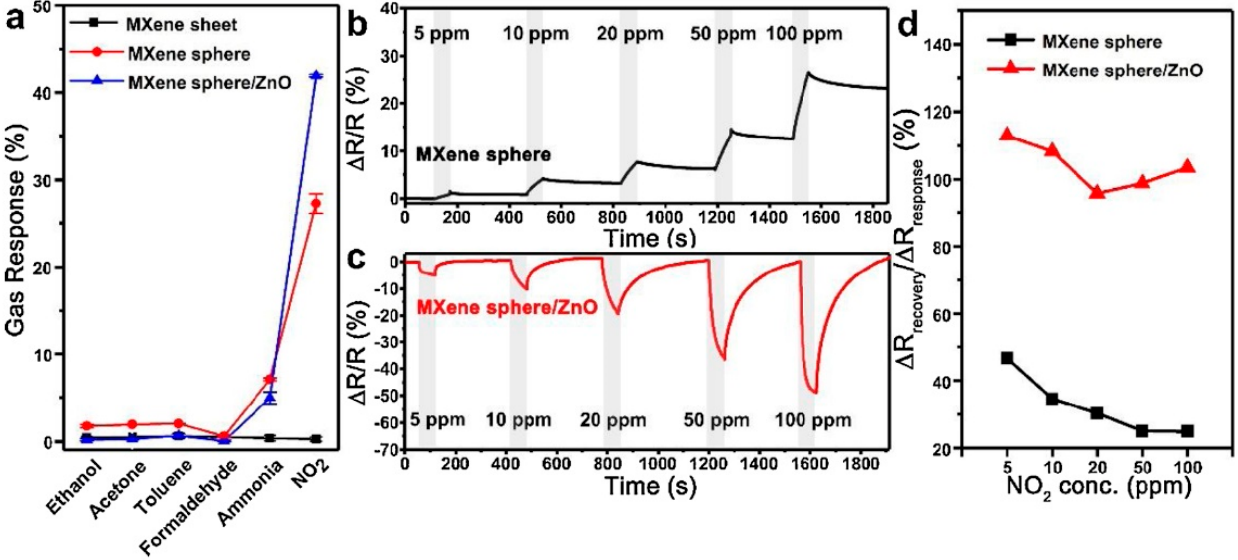
Figure 19. The selectivity, concentration sensitivity, and recovery characteristics of flexible gas sensors based on Ti 3 C 2 T x MXene sheet, 3D crumpled MXene sphere, and 3D crumpled MXene sphere/ZnO. ( a ) The gas response of sensors based on MXene sheets, MXene spheres, and MXene spheres/ZnO to various target gases at a concentration of 100 ppm. ( b , c ) Dynamic response/recovery curve of sensors based on MXene spheres and MXene spheres/ZnO to NO 2 at concentrations of 5, 10, 20, 50, and 100 ppm at 70% RH. ( d ) The recovery rate ( ∆ R recovery / ∆ R response ) of sensors based on MXene spheres and MXene spheres/ZnO for different concentrations of NO 2 . Reprinted with permission from [122]. Copyright 2021: Elsevier B.V.